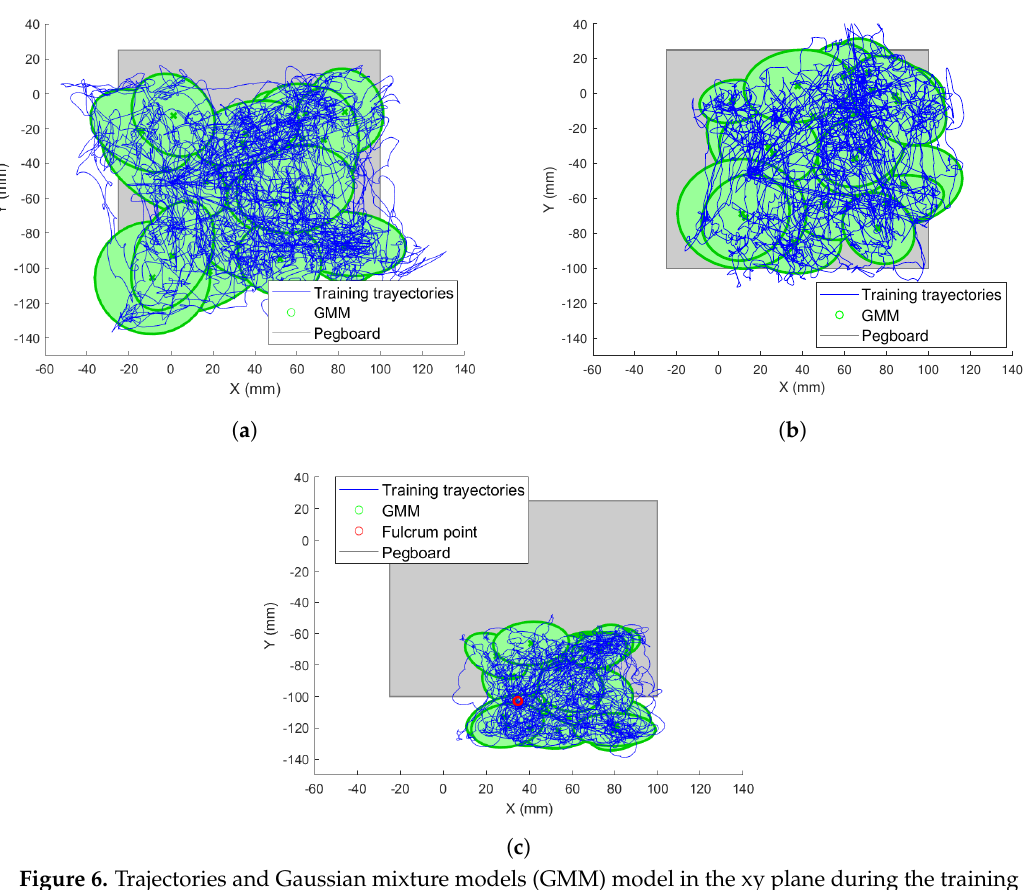
Figure 6. Trajectories and Gaussian mixture models (GMM) model in the xy plane during the training stage: ( a ) left tool; ( b ) right tool; and ( c ) camera.